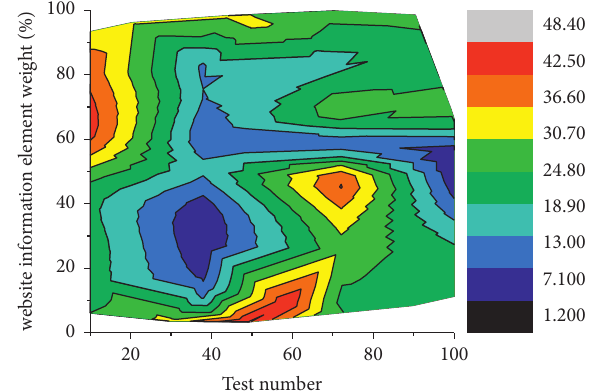
Figure 8: Weight distribution of website information and com- munication